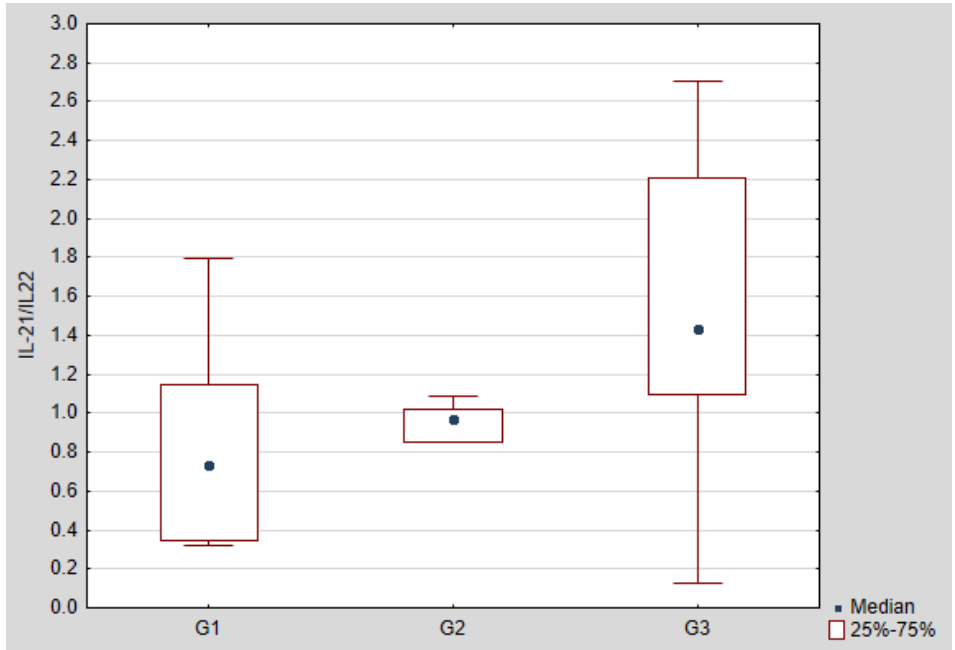
Figure 10. IL-21/IL-22 ratio in the peritoneal fluid of women with ovarian cancer depending on the degree of differentiation G1 (well differentiated), G2 (moderately differentiated), G3 (poorly differ- entiated).